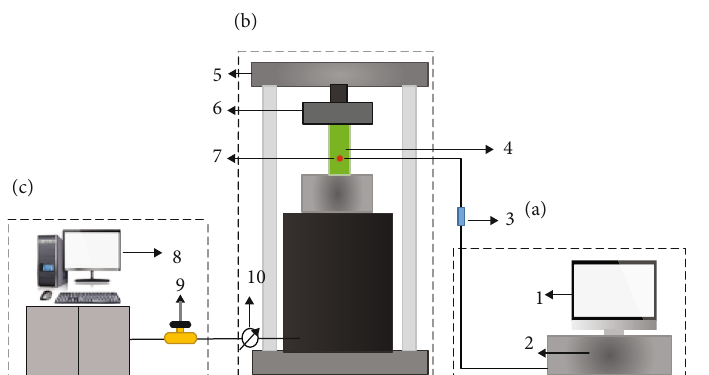
Figure 4: Systematic experimental diagram of the acoustic emission system and uniaxial compression system. (a) AE data processing system, (b) Loading control system, and (c) Loading and signal collecting system: (1) computer (for data display), (2) AE monitoring device (3) preampli fi er, (4) coal sample, (5) servo hydraulic press, (6) press head, (7) AE sensors ( × 4), (8) computer (for loading control), (9) valve, and (10) pressure gauge.